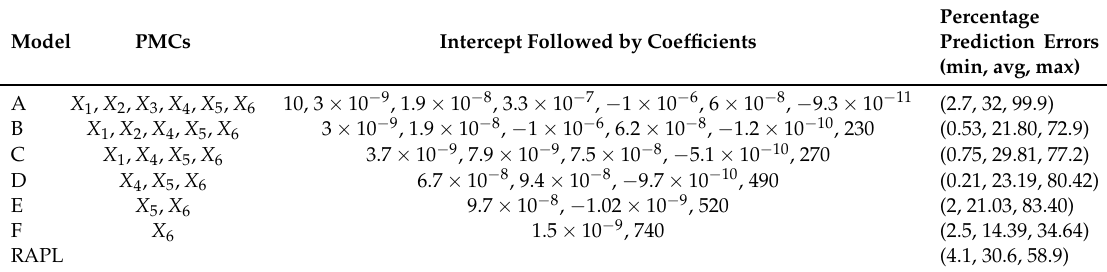
Table 7. Linear predictive models (A-F) with intercepts and RAPL with their minimum, average and maximum prediction errors.